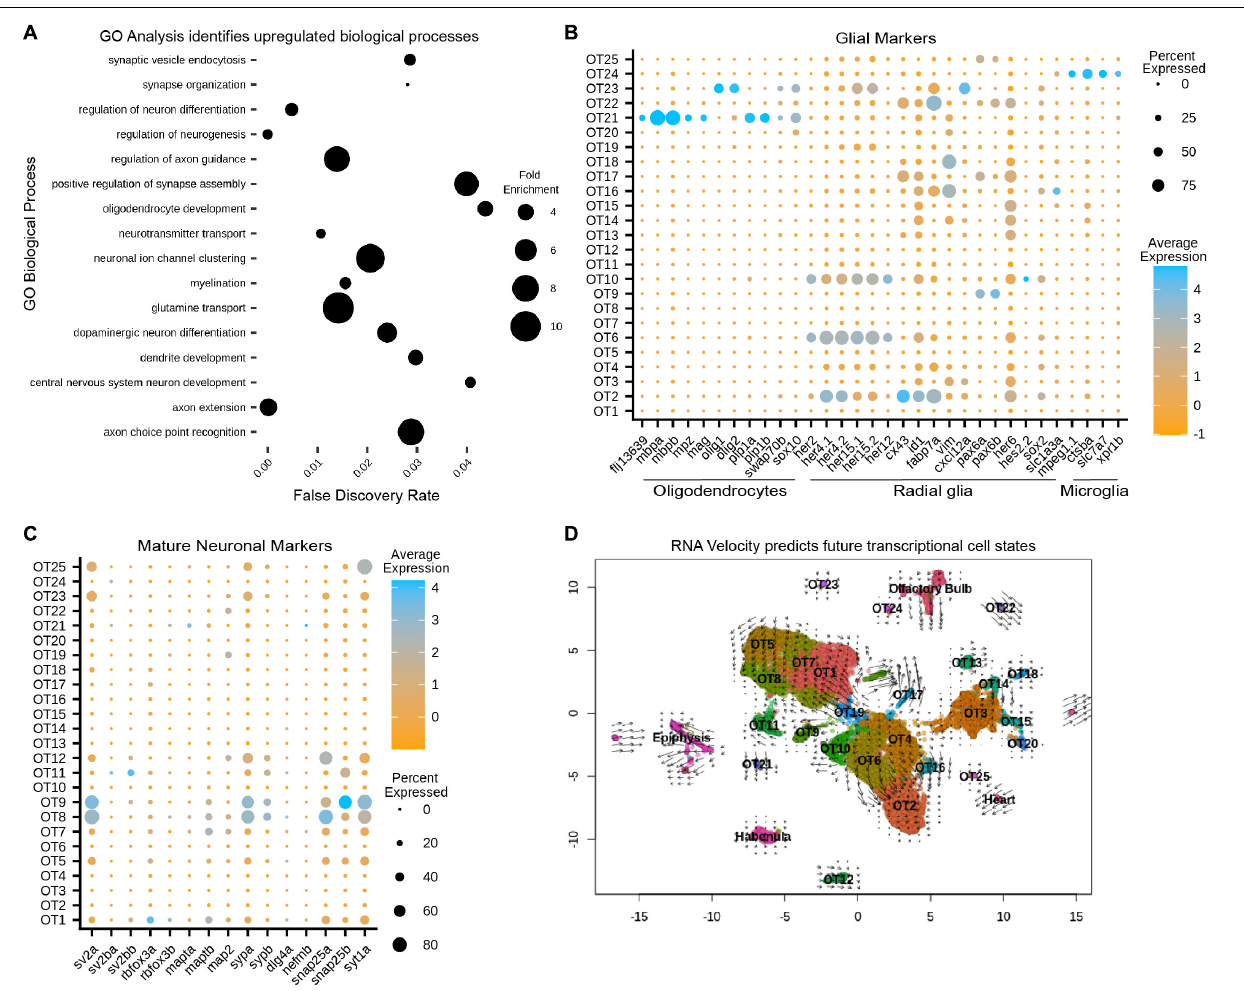
FIGURE 3 | Gene ontology (GO) and RNA velocity analysis reveals upregulated biological processes and predict future transcriptional cell states. (A) Upregulated processes in all 13,320 putative tectal cells. Whole dataset GO analysis was performed on all significant ( p < 0.05) differentially expressed genes (see also Supplementary Table 2 ). Processes of note include regulation of axon guidance, positive regulation of synapse assembly, glutamine transport, and oligodendrocyte development, suggesting the presence of immature/mature neuronal populations and glial cells (see also Supplementary Tables 3, 6 ). (B) Cluster analysis of glial markers identifies OT21/OT23 as oligodendrocytes; radial glial markers are found in various populations including OT6 and OT10; OT24 is likely microglial (see also Supplementary Table 5 ). (C) Cluster analysis of manually curated neuronal markers shows several mature populations including OT8 and OT9 (see also Supplementary Table 4 ). (D) RNA velocity with original UMAP cluster embeddings. Shorter arrows or dots connote more mature cells. Arrows are vectors where direction indicates the predicted transcriptional state and magnitude indicates the degree of differentiation. BAM files from two temporal replicates were used to generate a matrix containing spliced:unspliced count ratios for each gene, where higher spliced counts indicate a more processed form of the gene and lower spliced counts indicate newly “born”